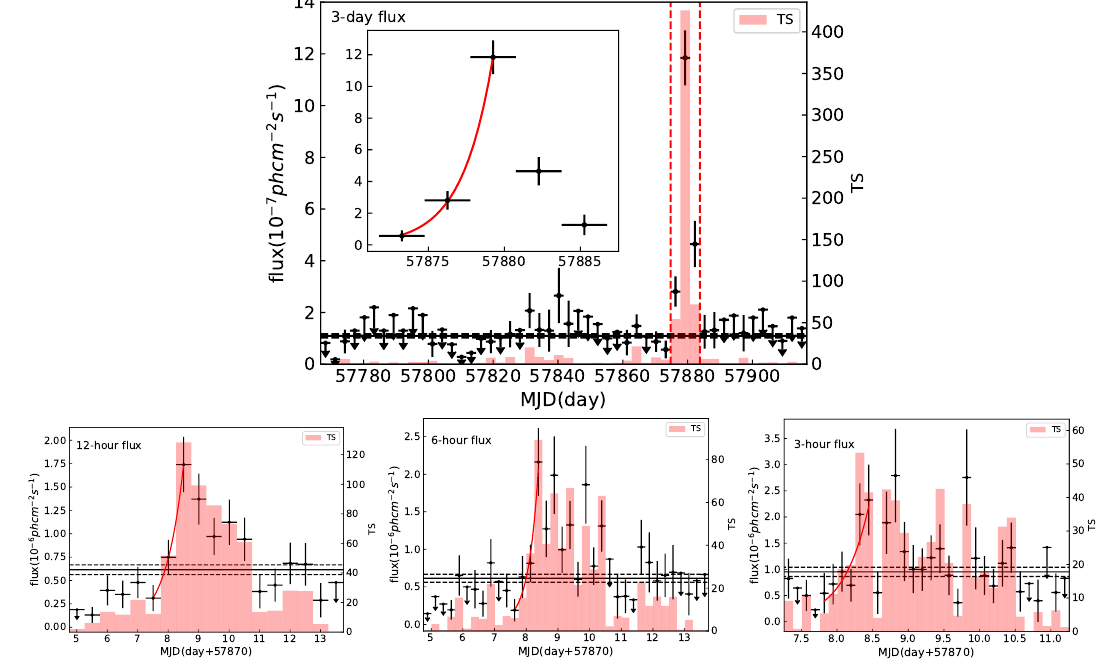
Figure 1. Fermi -Large Area Telescope (LAT) γ -ray light curves of NVSS J053954 − 283956 corresponding to the flare from which the fast variability has been detected. The horizontal solid line along with two dashed lines in each panel represent the average flux and its 1 σ error range. The red histogram represents the TS value in each time bin. Red solid lines are exponential fits of the ascent phase of this flare. ( Top ) The 3-day time bin light curve, in which the flare is marked by two vertical red lines; ( Bottom ) Zoomed-in intraday γ -ray light curves from which the doubling timescale is constrained as short as one hour (in the source frame). This figure can be also seen in Li et al. (2018)